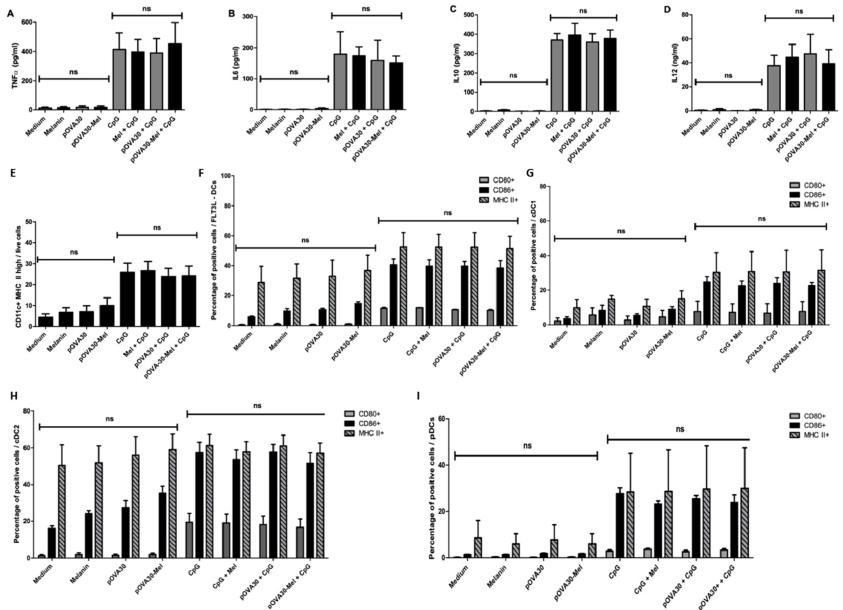
Figure 4. Effects of L-DOPA melanin and pOVA30-Mel nanoaggregates on maturation and activa- tion of FLT3L DCs. ELISA ( A – D ) and flow cytometry analysis ( E , F ) of cultures of bone marrow- derived dendritic cells (with FLT3L and low dose GM-CSF) after 24 h in vitro incubation with mel- anin, pOVA30, pOVA30-Mel, and CpG; melanin and CpG, pOVA30, and CpG; pOVA30-Mel and CpG; or medium as the negative control (5 × 10 5 cells/mL; 2 mL/well). Concentrations used for the different solutions: melanin at 4 μ g/mL, pOVA30 at 2 μ g/mL, CpG at 1 μ g/mL. Concentrations of